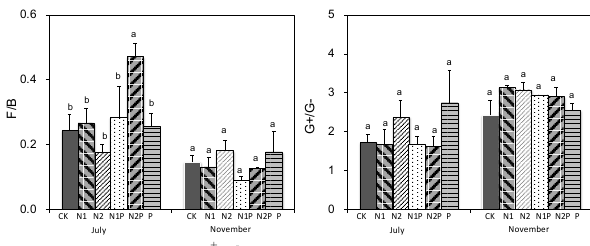
Figure 4. Ratios of F / B and G + / G − to N and P additions to Chinese fir plantations (F / B: ratios of fungal PLFAs to bacte- rial PLFAs; G + / G − : ratios of Gram-positive bacterial PLFAs to Gram-negative bacterial PLFAs. Different lower-case letters in dif- ferent bars indicate significant differences when P